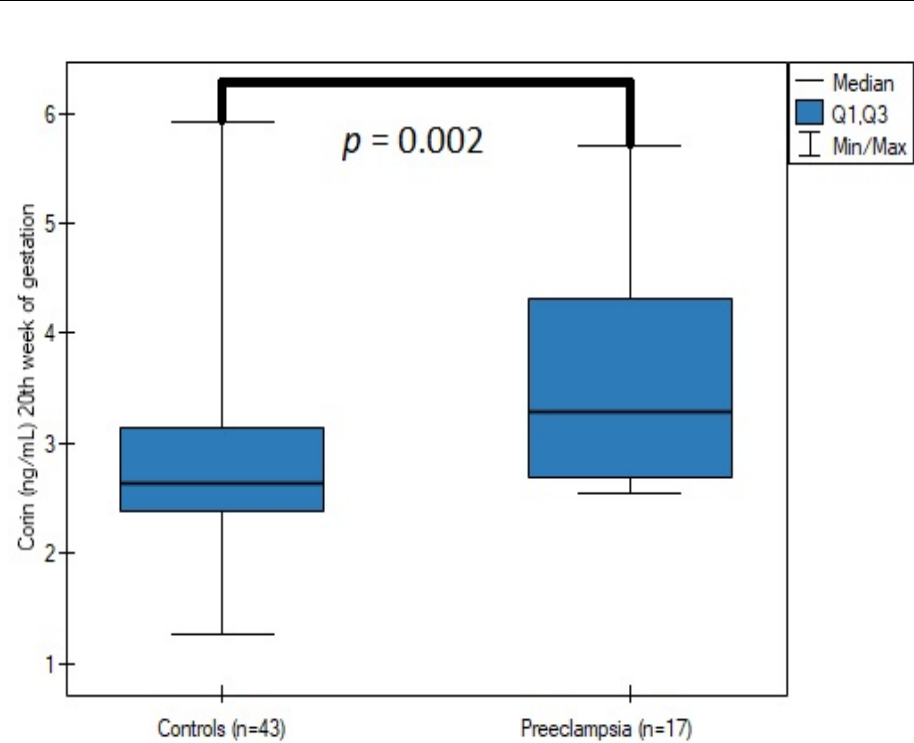
Figure 1. The comparison of corin serum concentrations at the 20th week of gestation between the patients with and without preeclampsia.